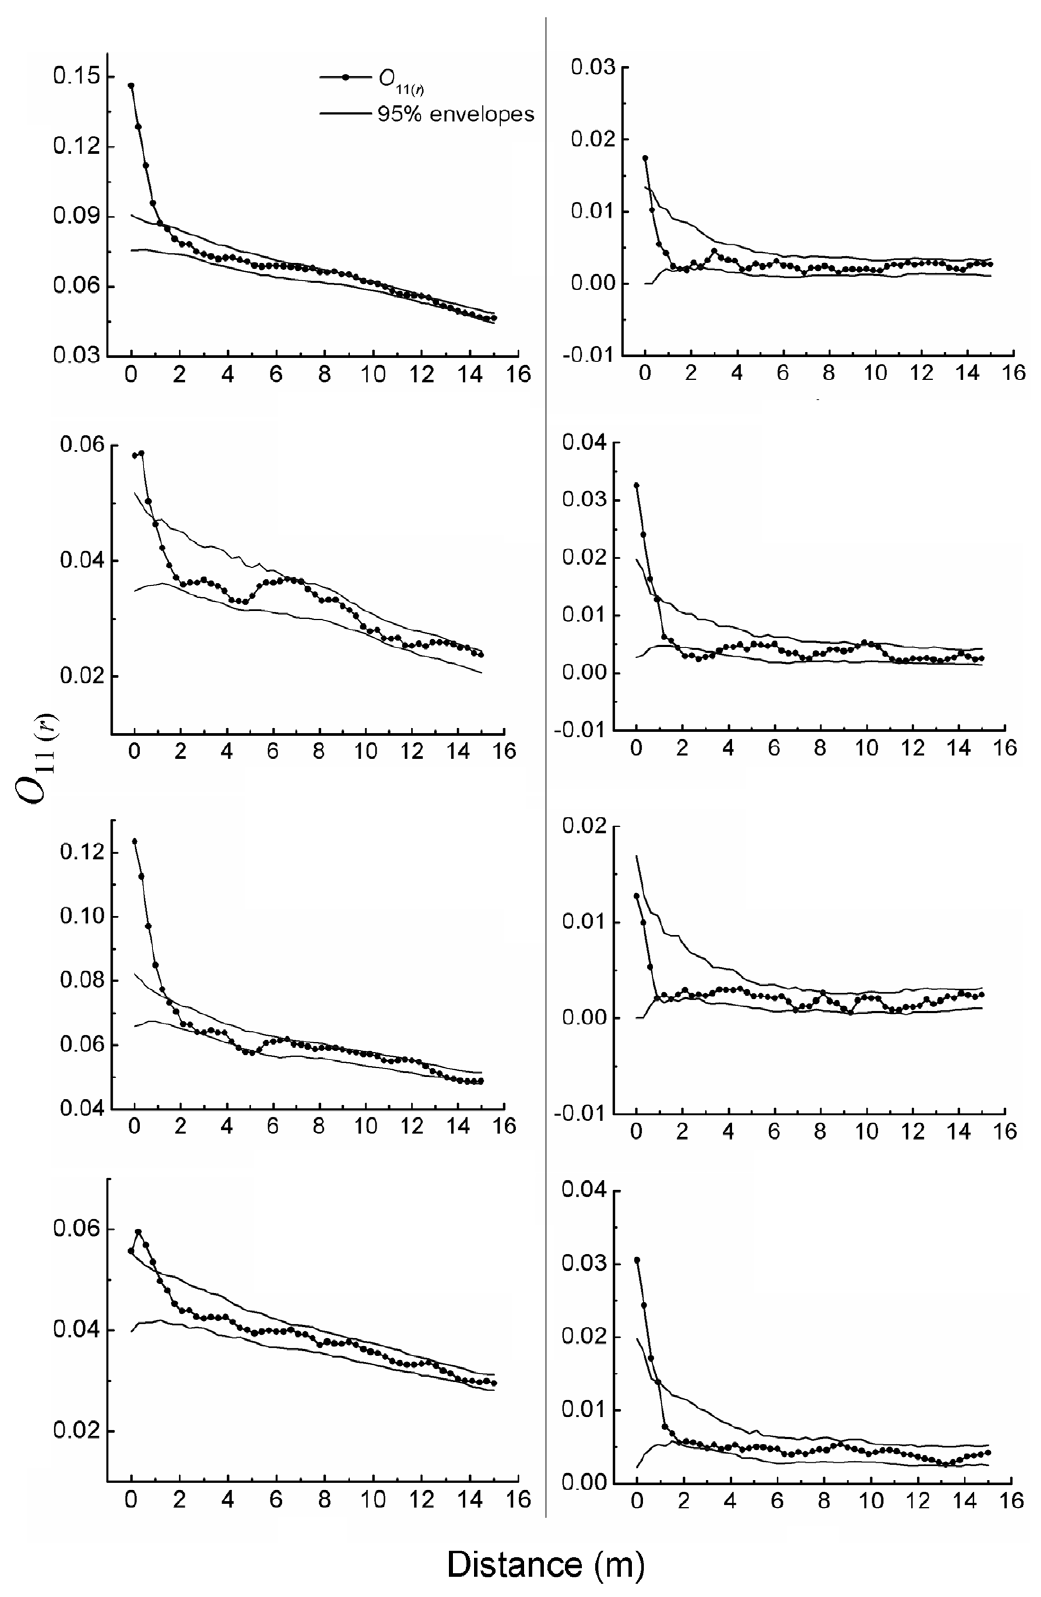
Figure 2. Spatial aggregation of A.ordosica saplings at the patch edges (left column, a) and the patch centers (right column, b), one sub-figure per plot.